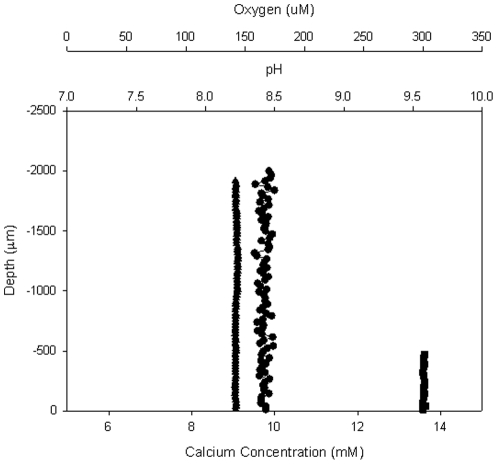
Microsensor profiles.Representative Ca2+ (•), O2 (▪), and pH (▴) microsensor profiles above bacterially colonised shell. 0 µm indicates the shell surface. Negative distances indicate the microsensor is above the shell, in the overlying water.